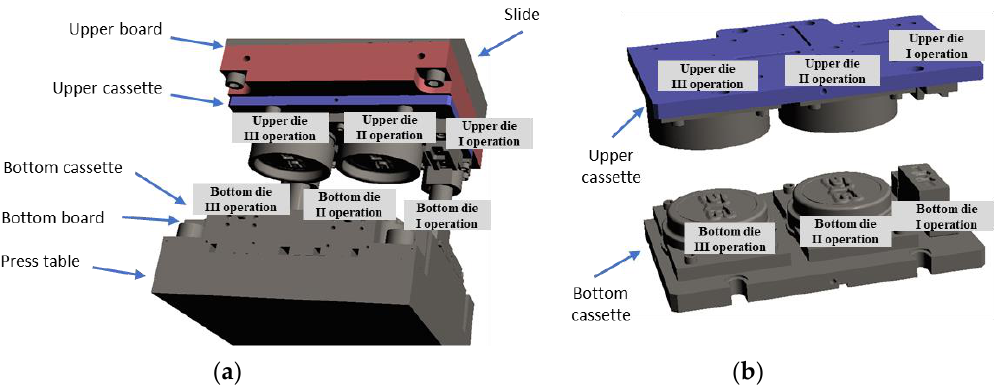
Figure 3. View of: ( a ) the CAD model of SMED system installed in main boards, ( b ) the CAD model of SMED system with the mounted tools assigned for forging in three operations.